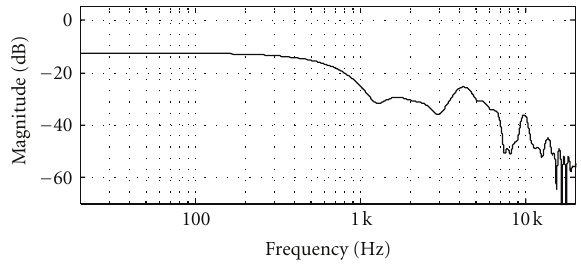
Figure 10: Isolation curve of an ARA